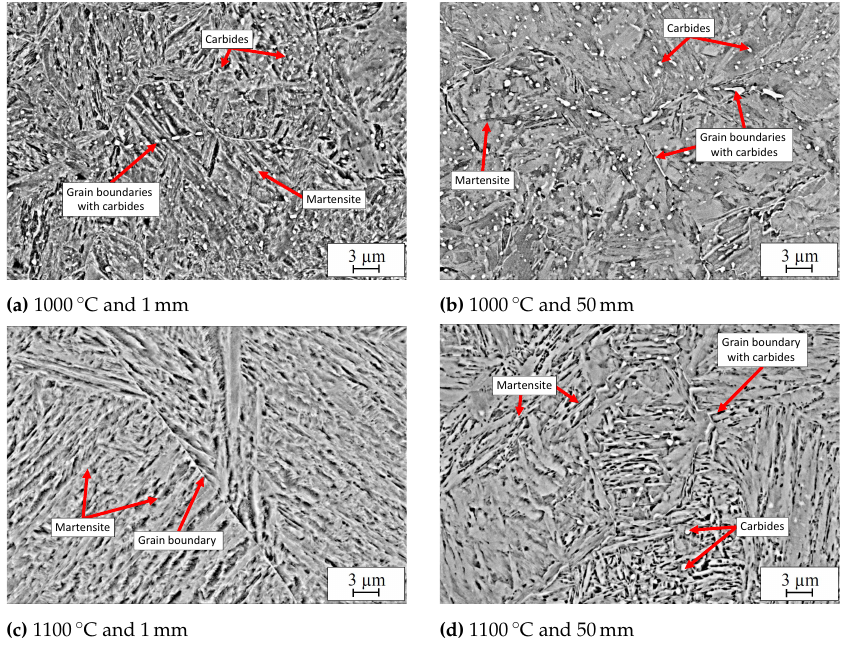
Figure 17. Selected micrographs (SEM: EHT=20kV, Detector=HDBSD, WD=6.2mm to 7.5mm) of X30Cr13 as a function of the austenitizing temperature and the distance from the quenched end face and thus the cooling rate: (a) 1000 ◦ C and 1mm, (b) 1000 ◦ C and 50mm, (c) 1100 ◦ C and 1mm, (d) 1100 ◦ C and 50mm.